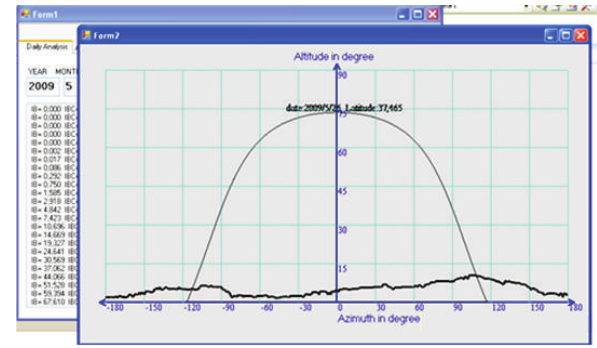
Figure 13: The screenshot of the developed software for application day.